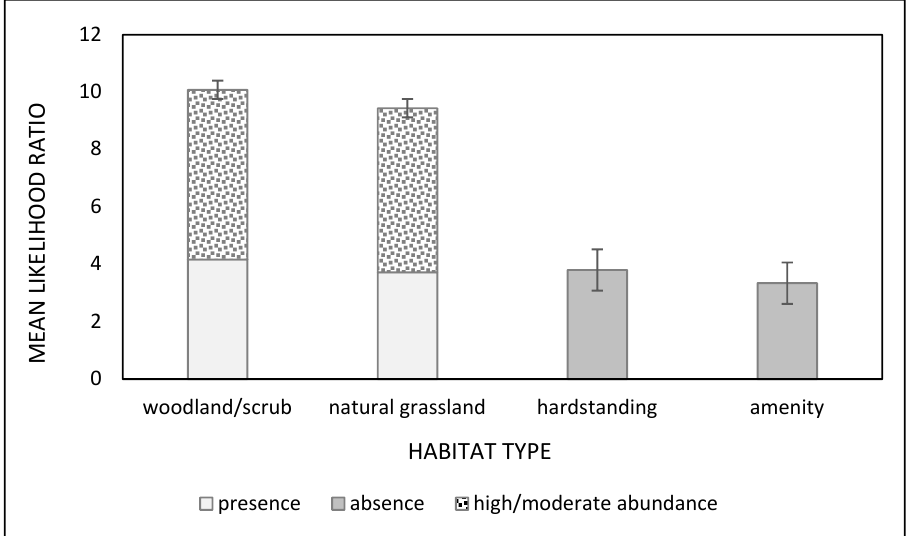
Figure 3. Mean likelihood ratios ± standard error, for presence and absence, and moderate and high relative abundance of all gastropods. Data were derived from quadrat data across 7 study sites in Brighton and Hove and surrounding areas, England, UK.